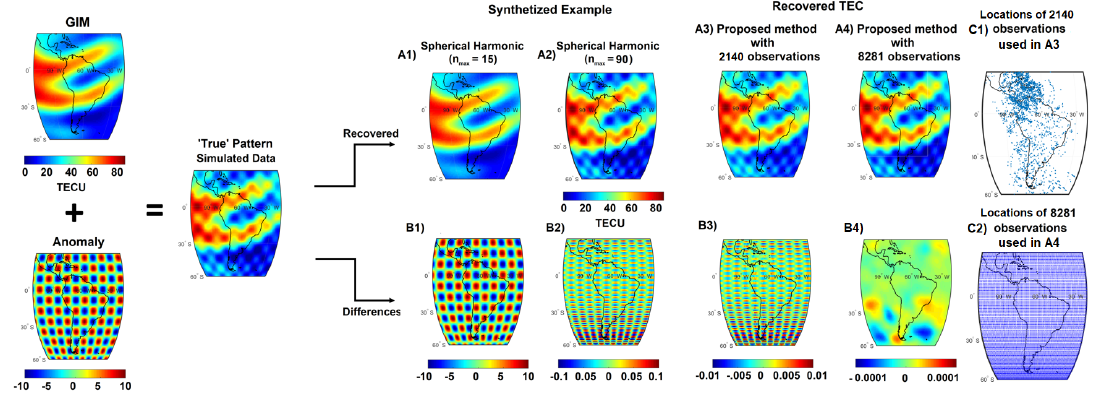
Figure 3. A synthetic example to demonstrate the ability of the proposed method for the recovery of regional VTEC anomalies. The true VTEC signals are introduced using the GIM/CODE data over South America on 21 December 2013 at 00:00 UT. Two of the top maps correspond to a simple synthesizing using the spherical harmonics expansion up to degree and order n = 15 ( A1 ) and n = 90 ( A2 ). The recovered VTEC estimates after implementing the Bayesian update following the procedure of Figure 1 are shown in ( A3 ) and ( A4 ). The bottom four maps ( B1 , B2 , B3 and B4 ) correspond to the differences between those of top ( A1 , A2 , A3 and A4 ) with the ‘true’ pattern on left. The spatial distribution of VTEC estimates used for modelling ( A3 ) is shown in ( C1 , 2140 observations) and that of ( A4 ) is shown in ( C2 , 8191